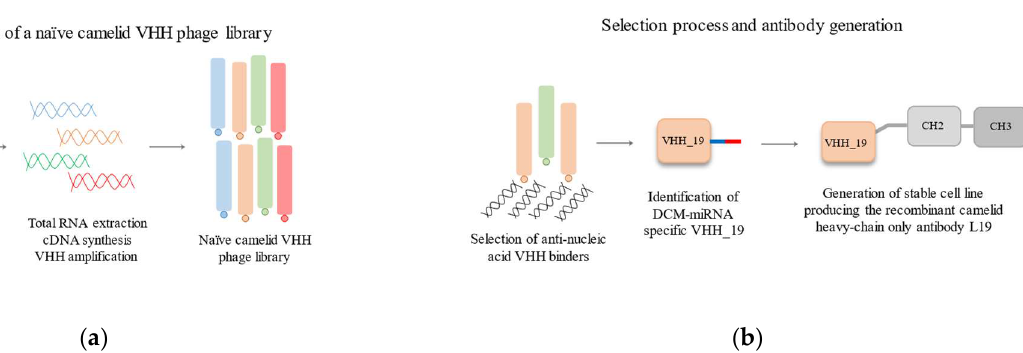
Figure 1. Schematic overview of performed phage display procedure to generate anti-short nucleic acid camelid binders. ( a ) The first step was the generation of a naïve camelid VHH phage library. The peripheral blood mononuclear cells (PBMCs) were isolated from the camelid whole blood. Next, the total RNA was extracted. cDNA synthesis and VHH amplification were performed to build a naïve camelid VHH phage library. ( b ) After several panning rounds, the potential anti-DCM-miRNA VHH_19 binder was identified. In order to produce the recombinant full-length camelid antibody, the DNA sequence was expanded by the introduction of the Fc region of camelid IgG2b instead of His (blue bar) and HA (red bar) tags.